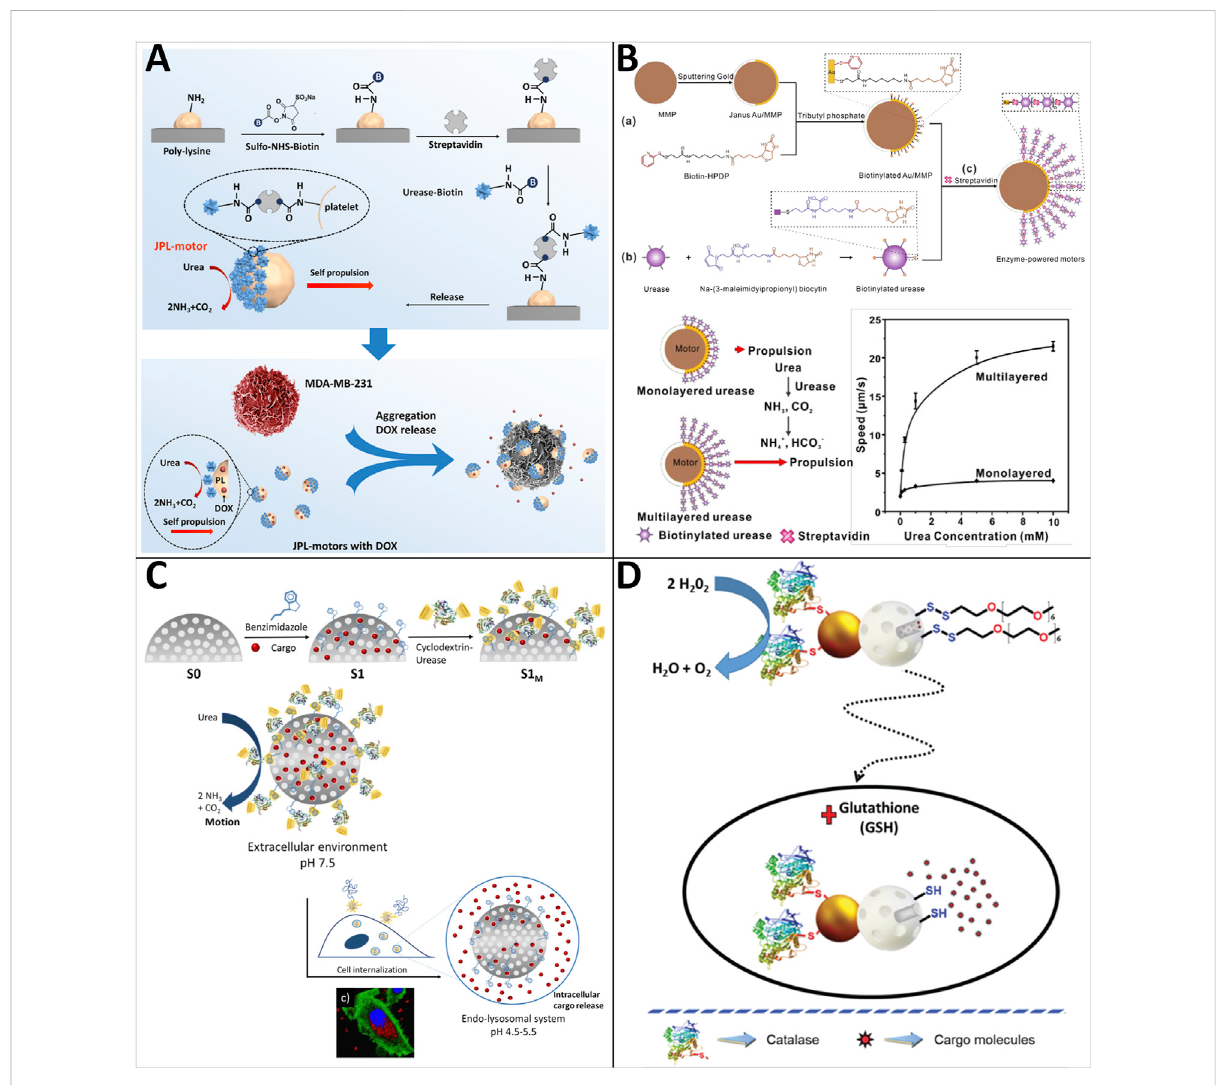
FIGURE 5 Motile drug delivery by enzyme-powered MNRs. (A) Enzyme-powered Janus platelet micromotor. (Tang et al., 2020) Copyright 2020. Reproduced with permission from American Association for the Advancement of Science. (B) Multilayer-urea-based Janus Au/magnetic microparticles. (Luo et al., 2020) Copyright 2020. Reproduced with permission from American Chemical Society. (C) Enzyme-powered gated mesoporous silica nanomotors. (Llopis-Lorente et al., 2019b) Copyright 2019. Reproduced with permission from American Chemical